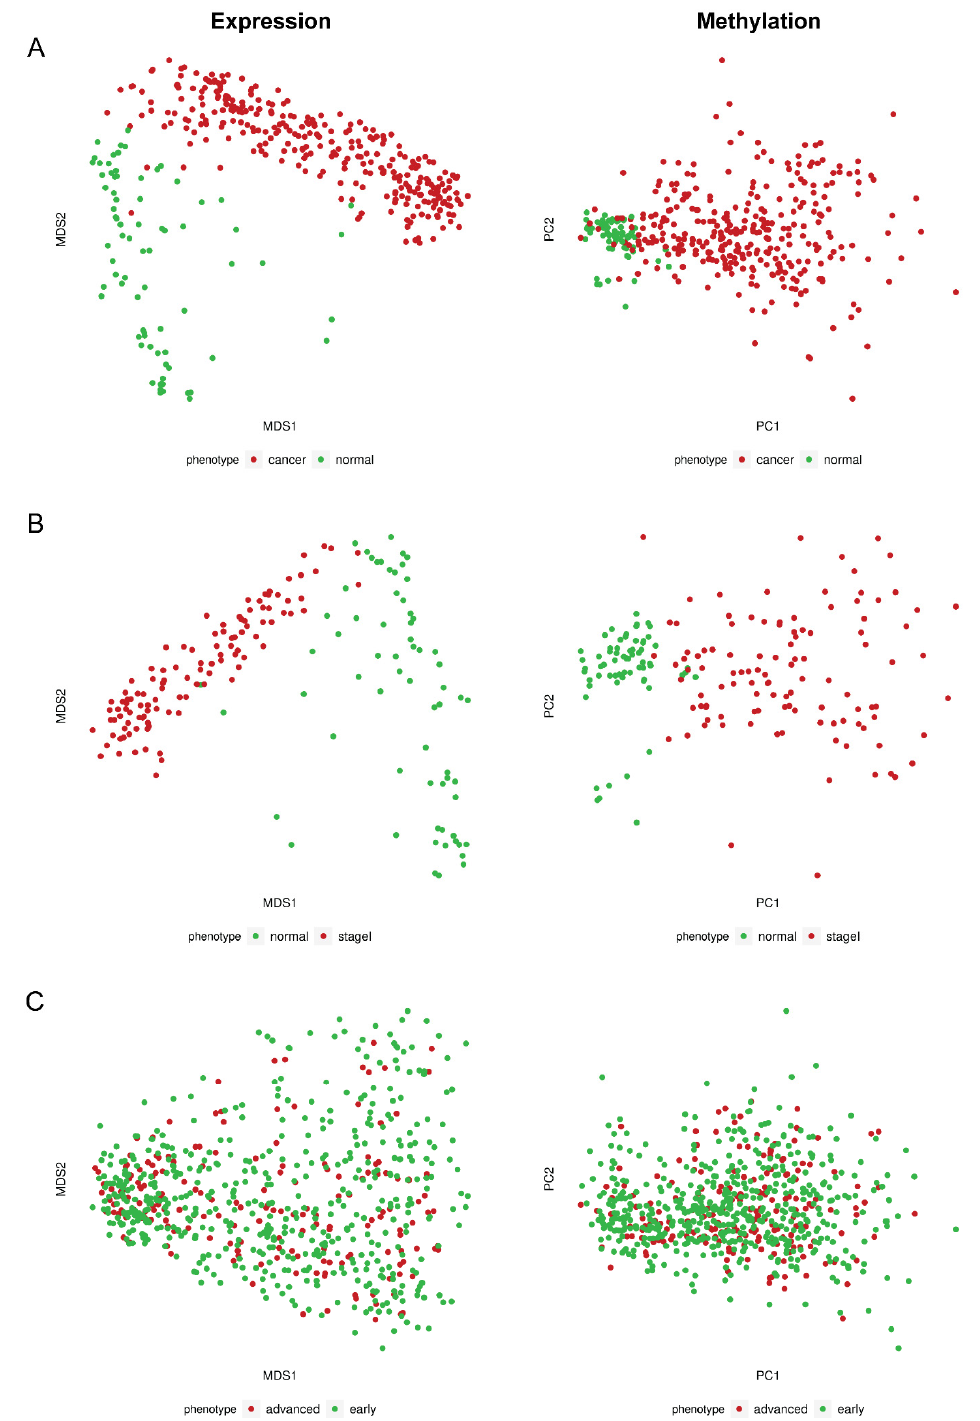
Figure 1. Dimensionality reduction plots for TCGA expression and methylation data. ( A ) MDS plot for normalized expression values of BrCa and normal breast tissue samples ( left ); PCA plot for level 3 beta methylation values of the same phenotypes ( right ). ( B ) MDS plot for normalized expression values of stage I BrCA and normal tissues ( left ); PCA plot for level 3 beta methylation values of the same phenotypes ( right ). ( C ) MDS plot for normalized expression values of advanced and early BrCA tissues ( left ); PCA plot for level 3 beta methylation values of the same phenotypes ( right ). MDS: Multidimensional scaling; PCA: principal component analysis.